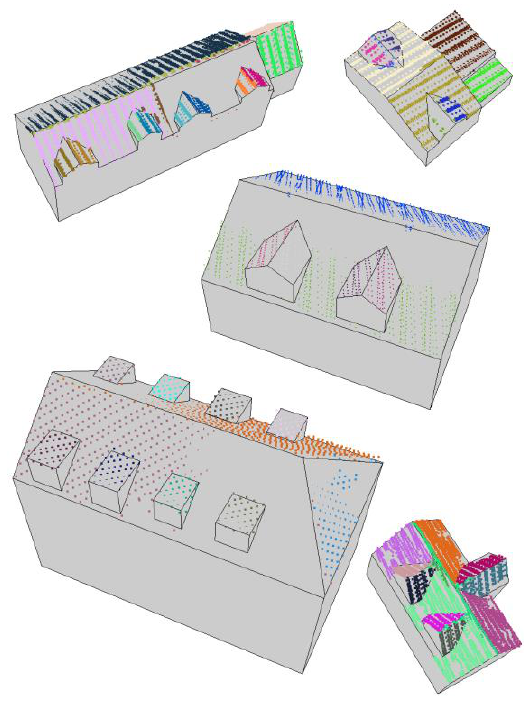
Figure 10. Some reconstructed buildings of the Vaihingen test data